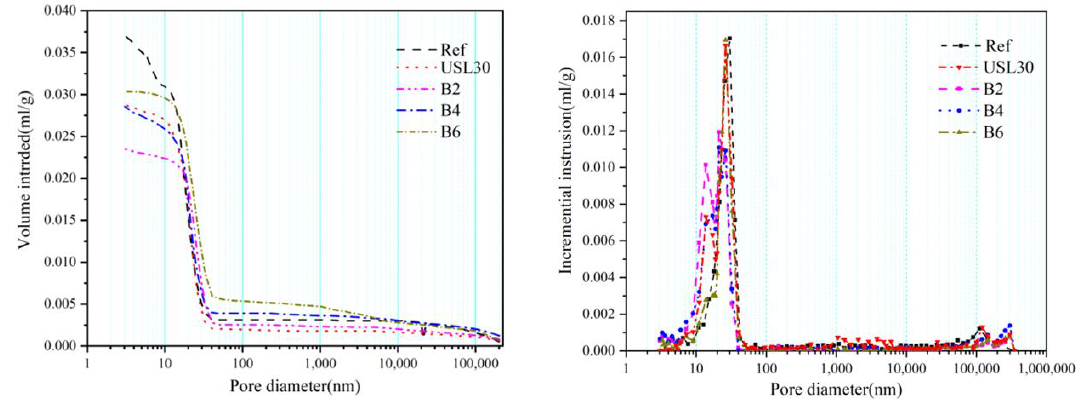
Figure 12. MIP results with USL or LS at 28 d. Table 5. Pore distribution of the UHPC.